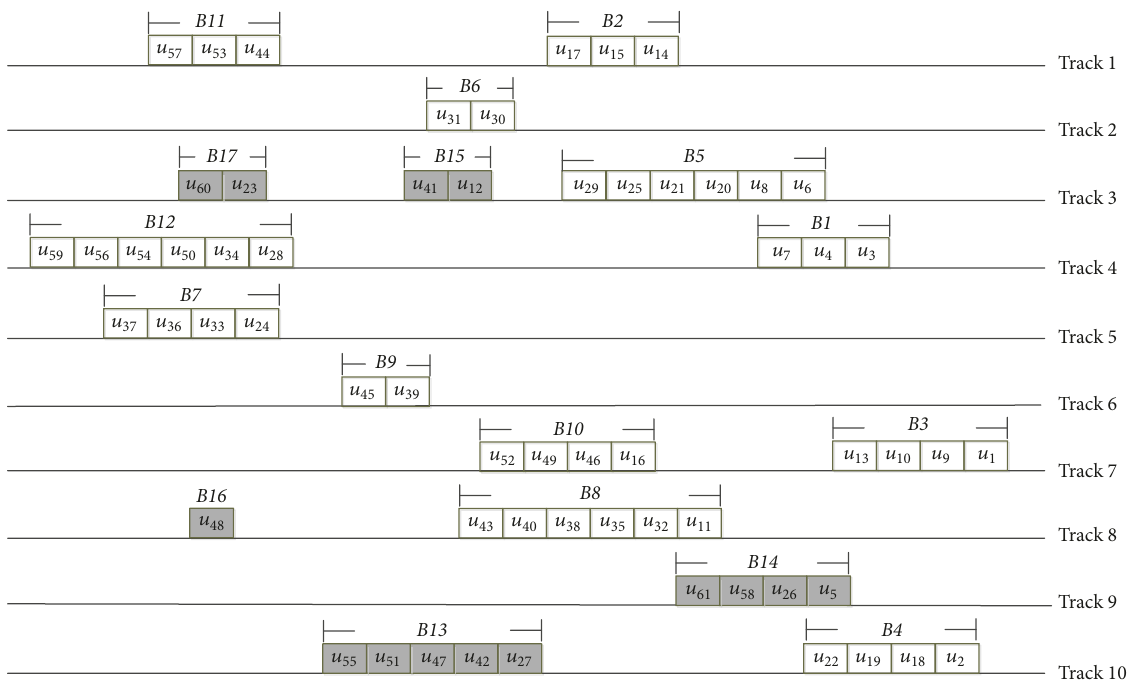
Figure 7: Track assignment with 10 tracks (without considering block sequence). Table 6: Computation time of CPLEX and Algorithm.